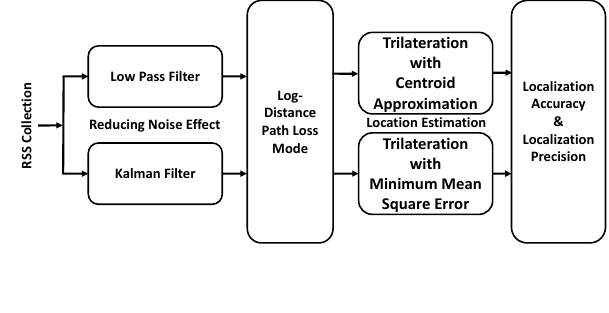
Figure 10. Proposed BLE based WILS